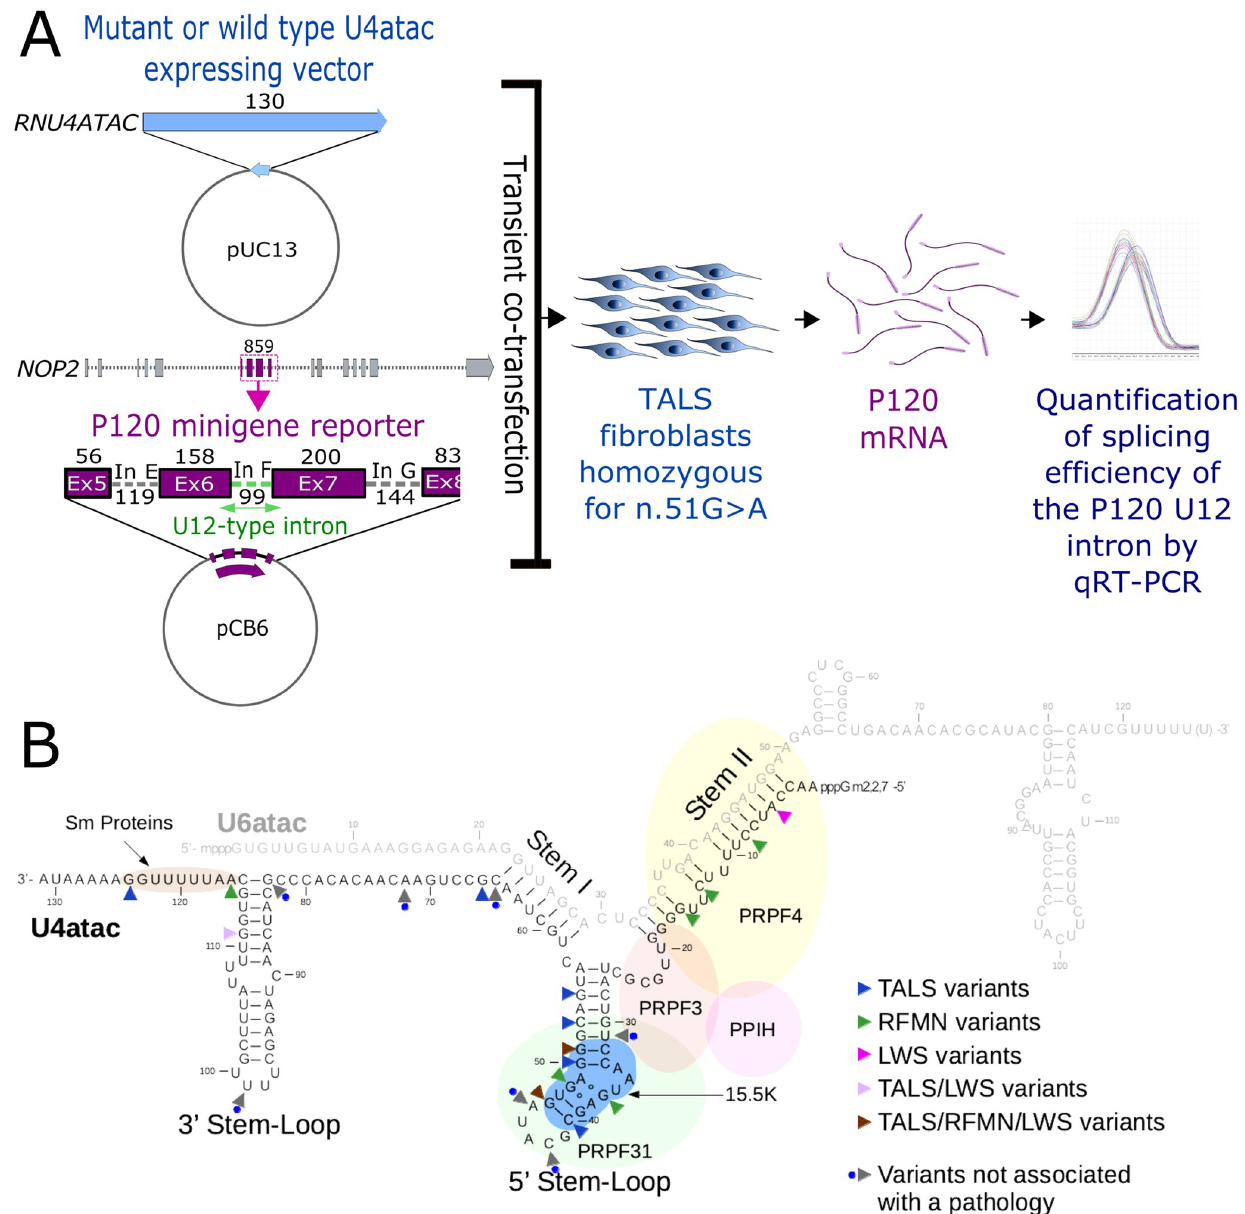
Fig 4. A . Schematic representation of the cellular assay. The pUC13 vector containing the mutant or wild type RNU4ATAC sequence and the PCB6 plasmid containing the P120 minigene reporter are transiently co-transfected into fibroblast cells derived from a TALS patient homozygous for n.51G > A. The P120 minigene reporter consists of exons 5–8 and introns E, F (U12-type intron) and G of the human NOP2 gene ( NOP2 Nucleolar protein ). Sizes are given in base pairs. The relative splicing efficiency of the F intron was determined by quantitative RT-PCR. B . Localisation of the 23 substitutions tested in the cellular assay. The RNU4ATAC genomic sequence is 130 nuceotide-long while the U4atac snRNA is 131 nucleotide-long due to a post-transcriptionally added adenylic acid residue on its 3 0